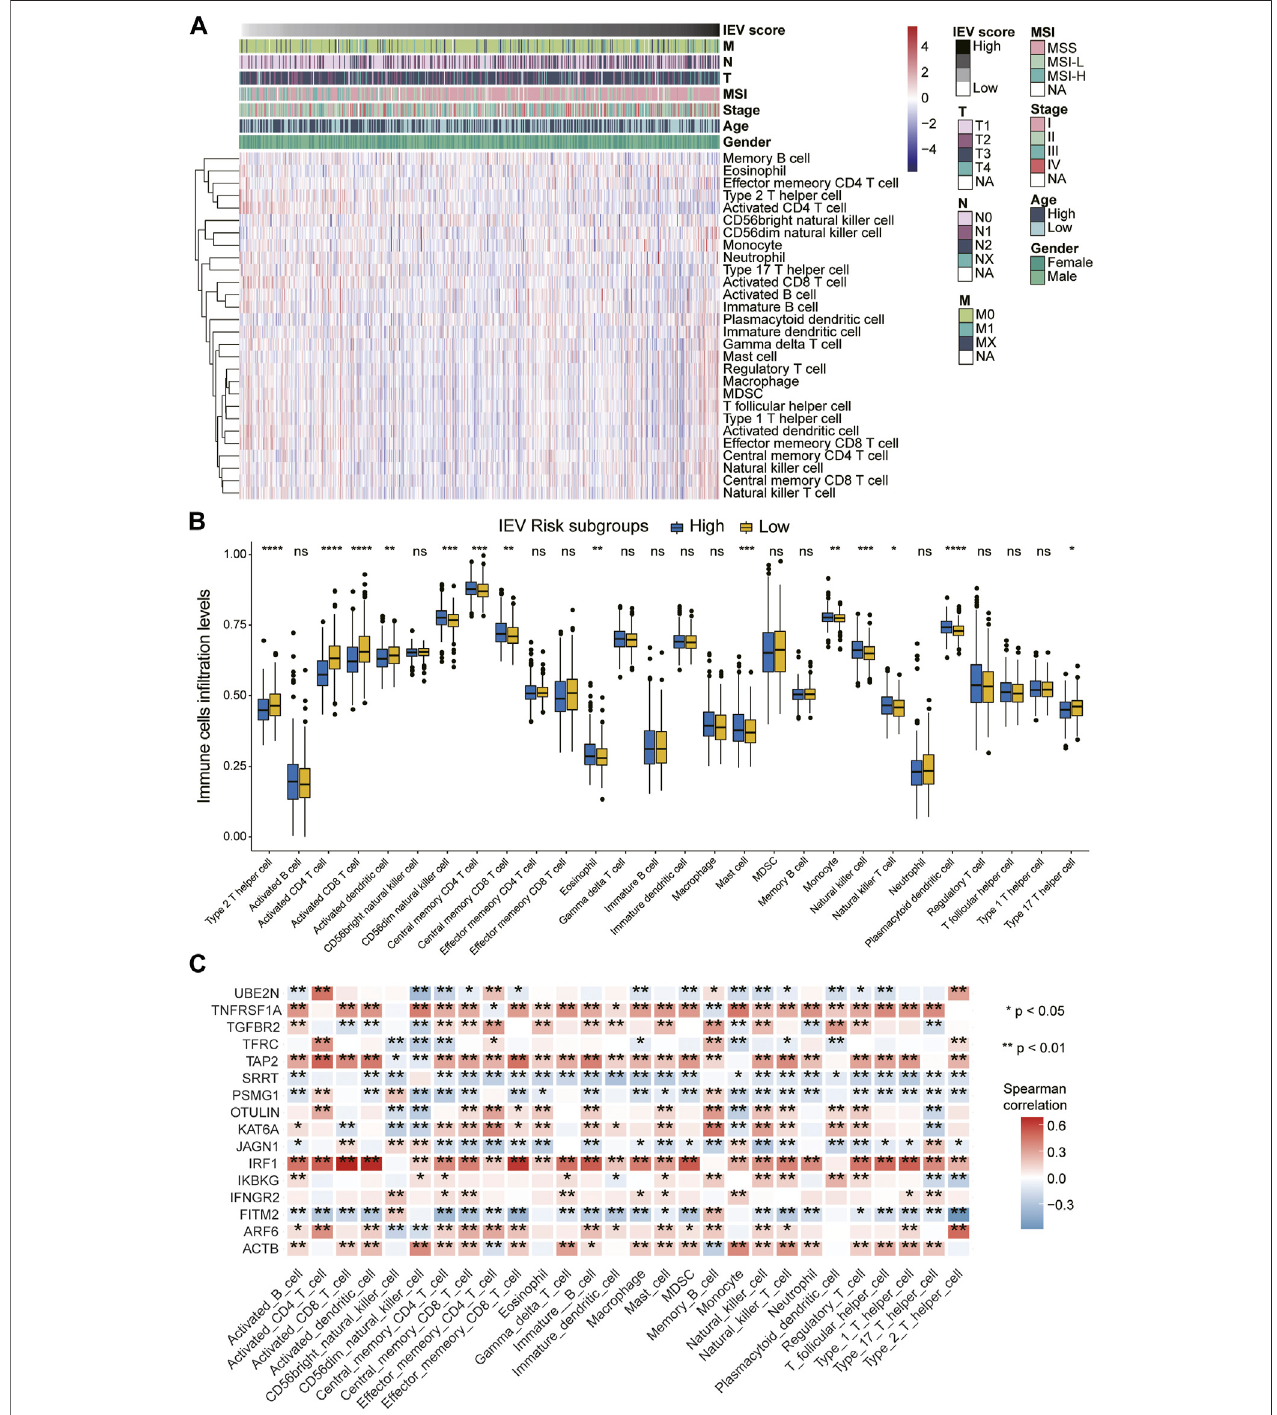
FIGURE 6 | orrelations between Immune evasion-related genes signature and immune cell in fi ltration levels of CC patients. (A) heatmap of the 28 immune cell in fi ltrationlevelsorderedbytheriskscoresandtheirassociationwithclinicopathologicalfeaturesincludingTNMstatus,MSIstatus,stage,age,andgenderintheCancer Genome Atlas (TCGA) cohort. (B) boxplot represents the 28 immune cell in fi ltration levels between low- and high-risk CC subgroups in the TCGA cohort. (C) the heatmap shows the Spearman correlations between the 28 immune cell in fi ltration levels and 16 screened immune evasion-related genes in the TCGA cohort.